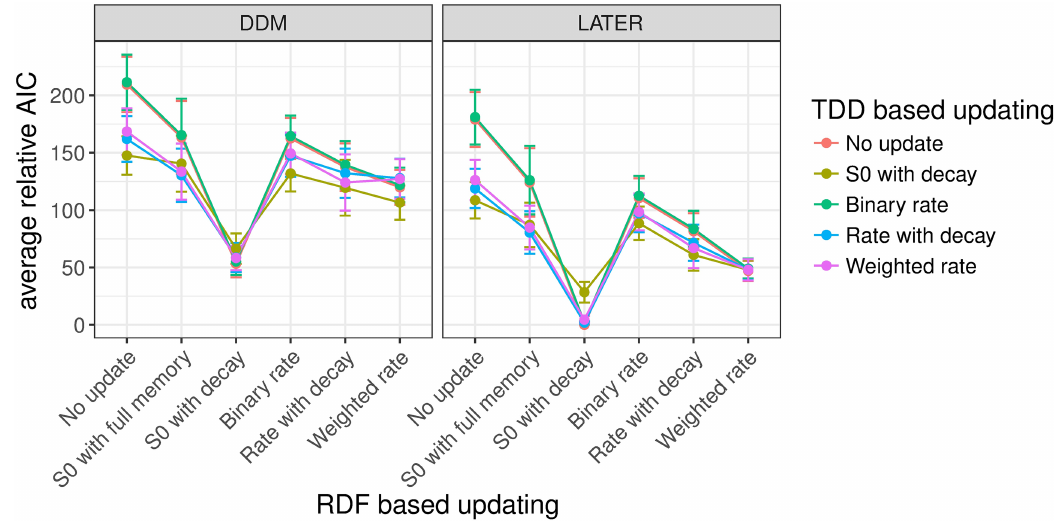
Fig 8. Mean relative AICs as a function of the tested models in Experiment 1. For each participant, the AIC of the best- performing model has been subtracted from the AIC for every model, before averaging across participants. Error bars indicate the standard error of the mean. The response-based updating rules are mapped onto the x-axis (RDF-based updating), while the dimension-based updating rules are indicated by different colors (TDD-based updating). The left-hand panel presents the results for the DDM, the right-hand panel for the LATER model. Only models with a non-decision time component are included in the figure. Models without a non-decision time component generally performed worse, and the best-fitting model included a non- decision time component (see also Table A in S4